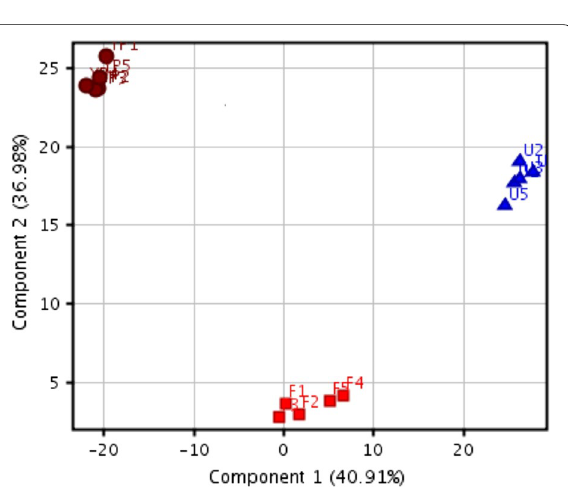
Fig. 5 PCA plot for extracted metabolites from the different media and investigated using GCMS. Component 1 vs. Component 2 of YPD media ( brown circle ), Fermented BSG media ( red square ) and Unfer- mented BSG media ( blue triangle